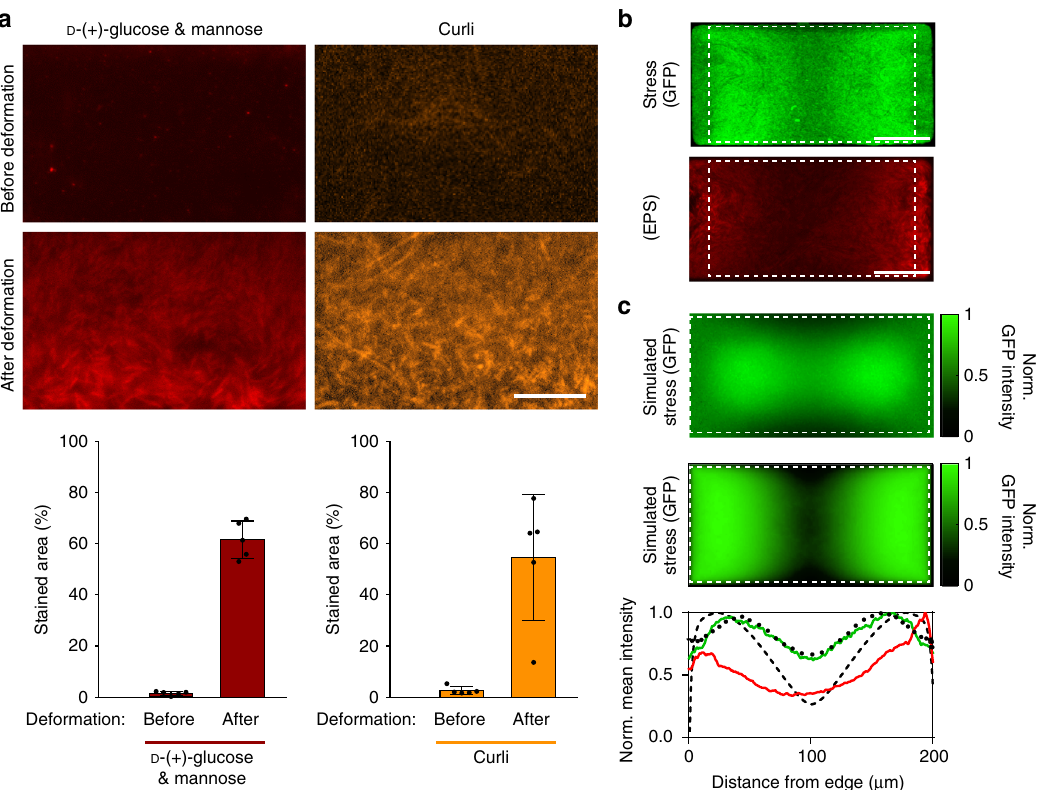
Fig. 2 Spatial correlation between expression of bio fi lm-associated cell surface structures and biochemical stress response. a Expression of bio fi lm- associated cell-surface structures, EPS D -( + )-glucose and mannose groups (red) and curli (orange), as detected using rhodamine-labeled concanavalin A (10 µ g/mL) and Congo Red dye (10 µ g/mL), respectively, before (top row) and after (bottom row) roof deformation in uropathogenic E. coli populations. Scale bar, 10 µ m. Bar graphs show major increases in expression of bio fi lm-related factors after roof deformation ( n = 5). Error bars are SD. b Spatial distribution of GFP, as a reporter of rpoH expression, and of rhodamine-labeled concanavalin A (EPS stain) in E. coli JM105 after roof deformation. Dashed lines show boundaries of the deformable roof. Scale bars, 50 µ m. c Agent-based (top) and mean fi eld (bottom) simulations of the stress response distribution reproduce the characteristic patterns observed in GFP and EPS expression. The intensity of green color encodes the stress response. The spatial correlation between the experimentally measured expressions of GFP and EPS and simulated stress responses (agent-based: black dotted curve; mean fi eld: black dashed curve) further supports the connection between mechanical stress and bio fi lm